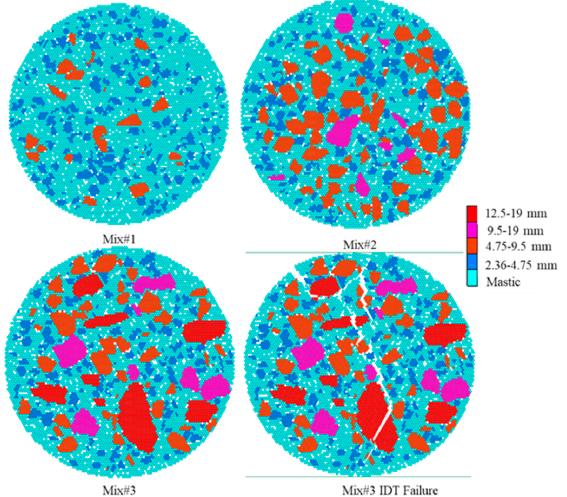
Figure 14. DEM Models for Parameter Validation Tests.